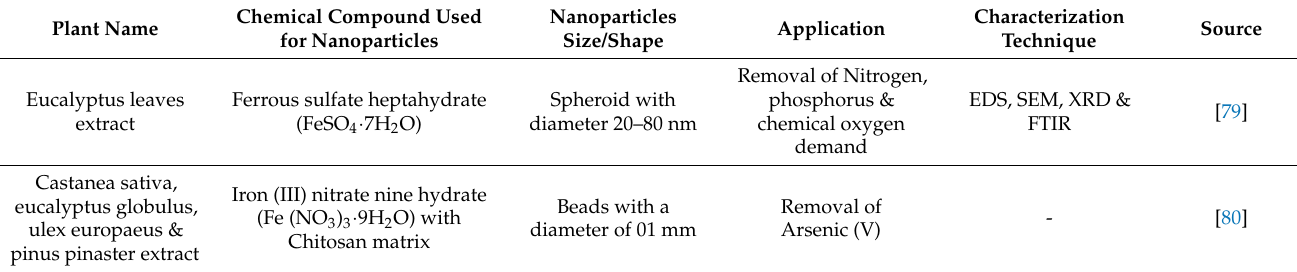
Table 5. Plant extract with a chemical compound is used in the preparation of